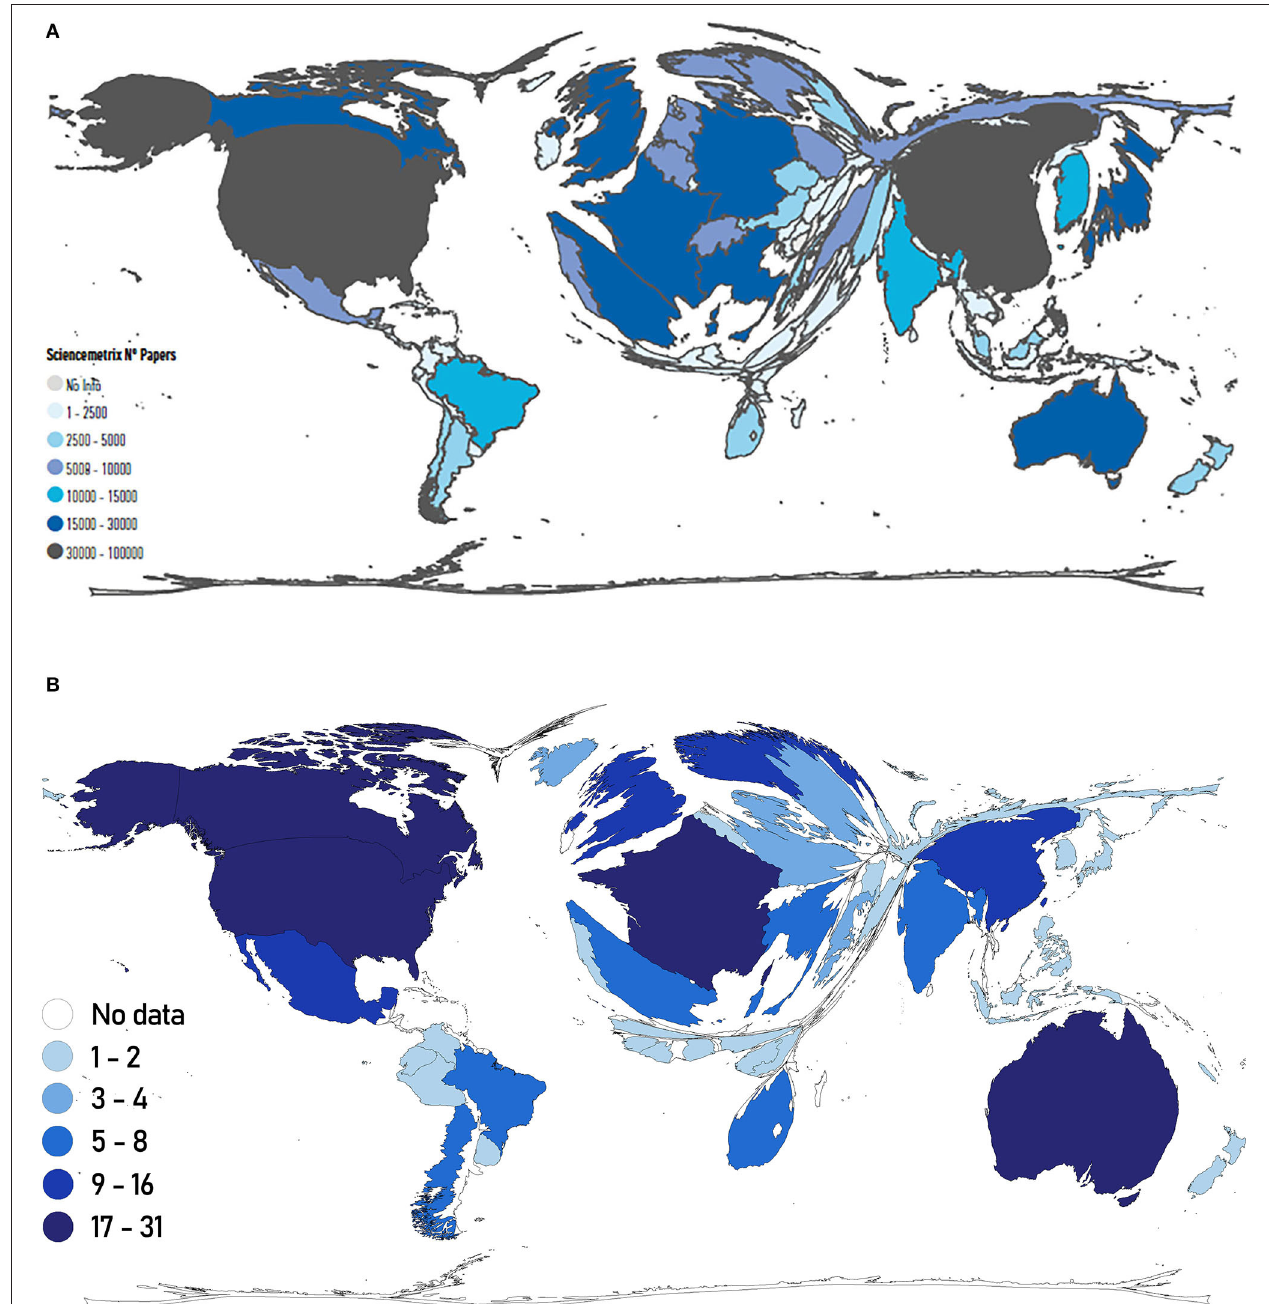
FIGURE 1 | Cartograms * depicting (A) Number of ocean science publications by country (from Figure 5.2 in IOC-UNESCO Global Ocean Science Report under the license: CC BY-NC-SA 3.0 IGO) and (B) indicative number of ecosystem modelers per country based on the author’s networks and knowledge. * In these cartograms the countries are deformed and rescaled in proportion to their relative research production by (A) Publication and (B) Percentage of ecosystem modelers.